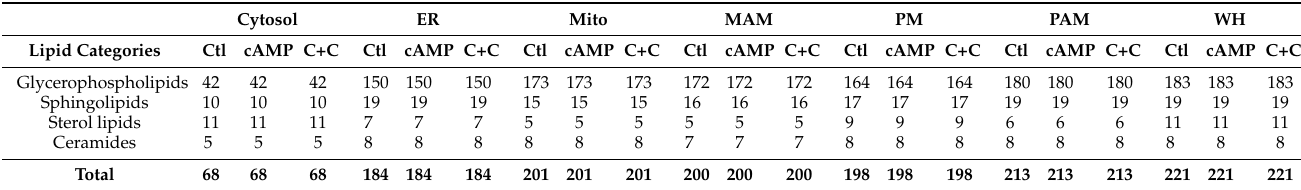
Table 1. Overview of subcellular